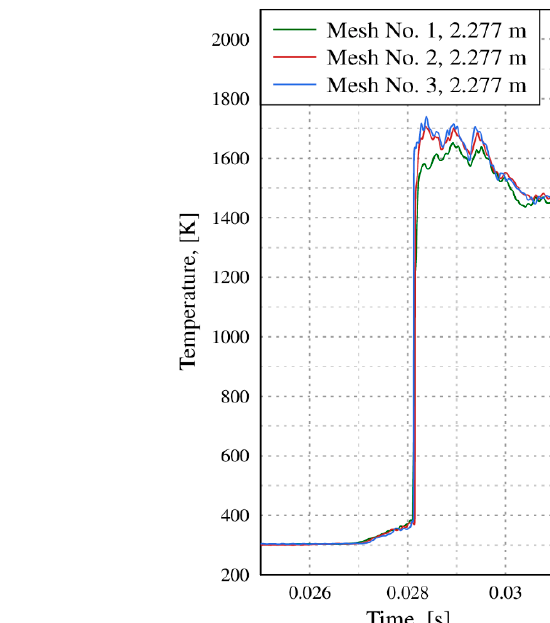
Figure 3. Comparison of meshes ( a ) 0% diluents, ( b ) 10% diluents, ( c ) 20% diluents, ( d ) 30% dilu- ents (Zimont correlation).